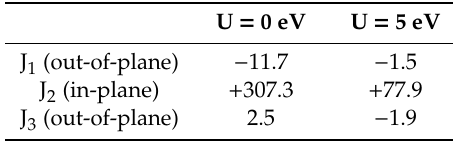
Table 3. Spin exchange interactions (in K) for H = 1 / 2 GGA + U.